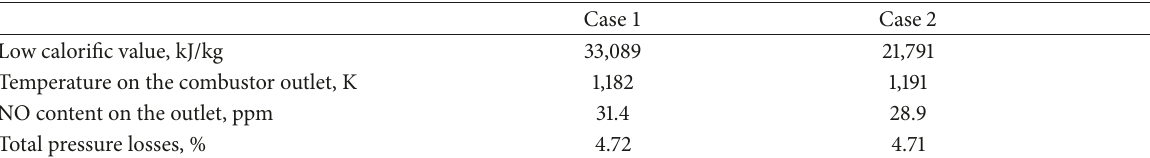
Table 7: Calculation results of the combustor which operates on various-content synthesis gas.